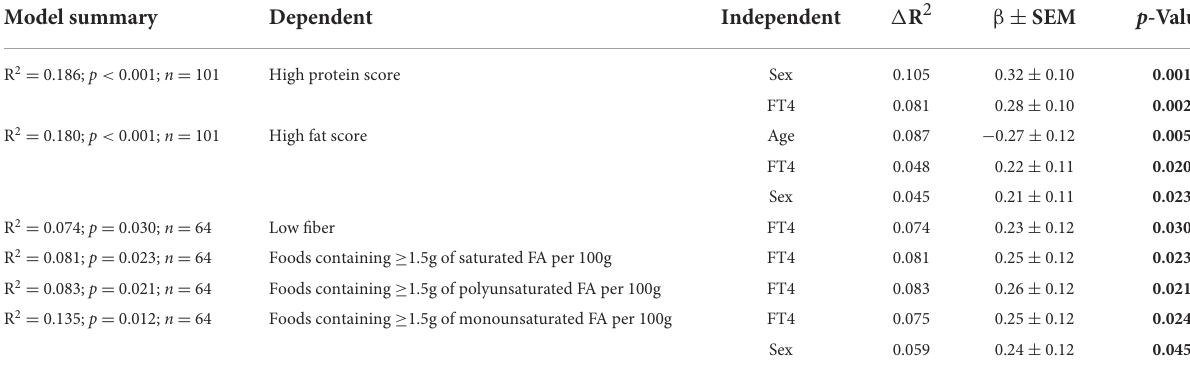
TABLE 3 Multiple regression analysis of food preferences in obese children and